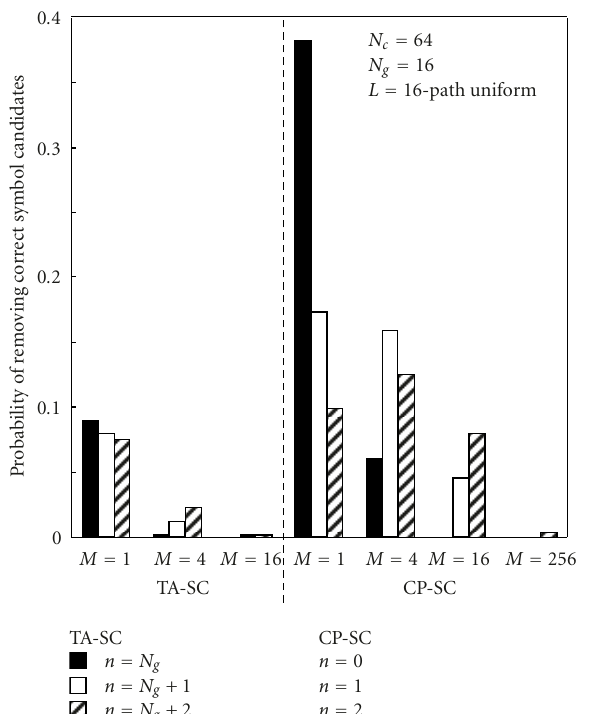
Figure 7: Required E b /N 0 for achieving BER = 10 − 4